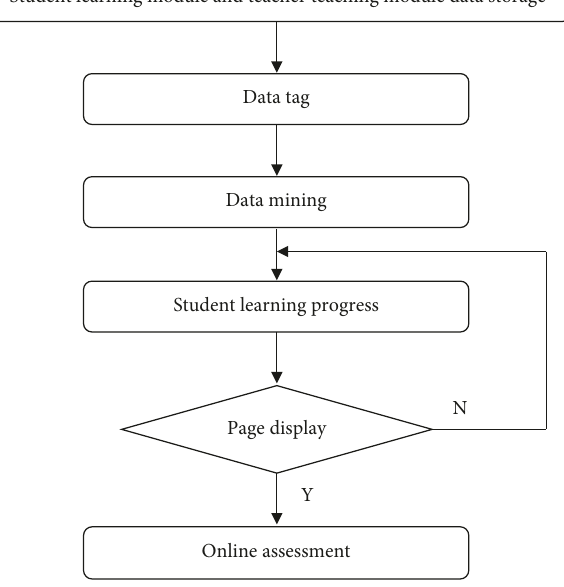
Figure 5: Evaluation